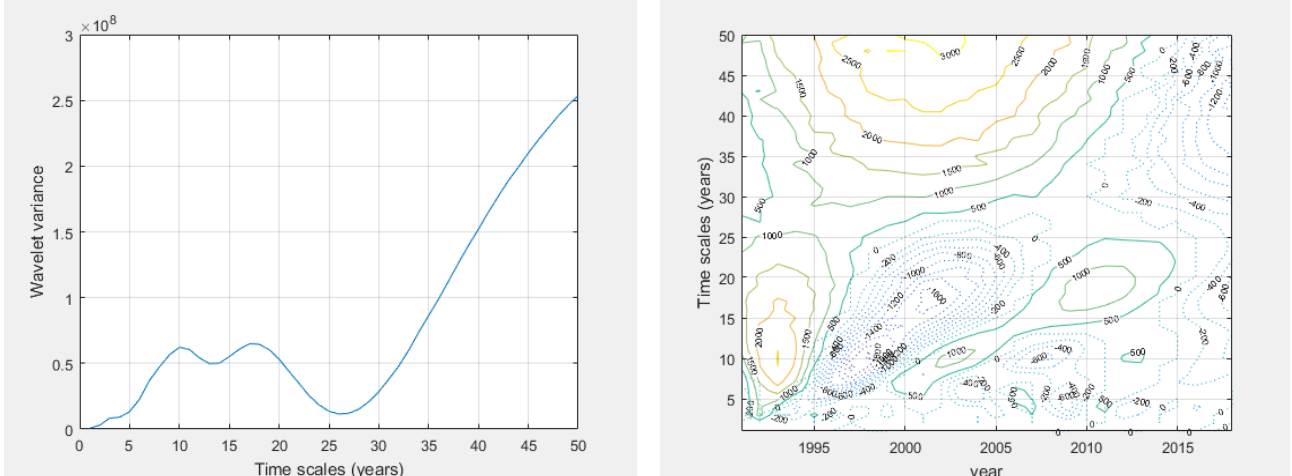
Figure 10. Wavelet variogram and coefficient real part contour plot of the number of people with reduced drinking water owing to drought from 1991 to 2018.